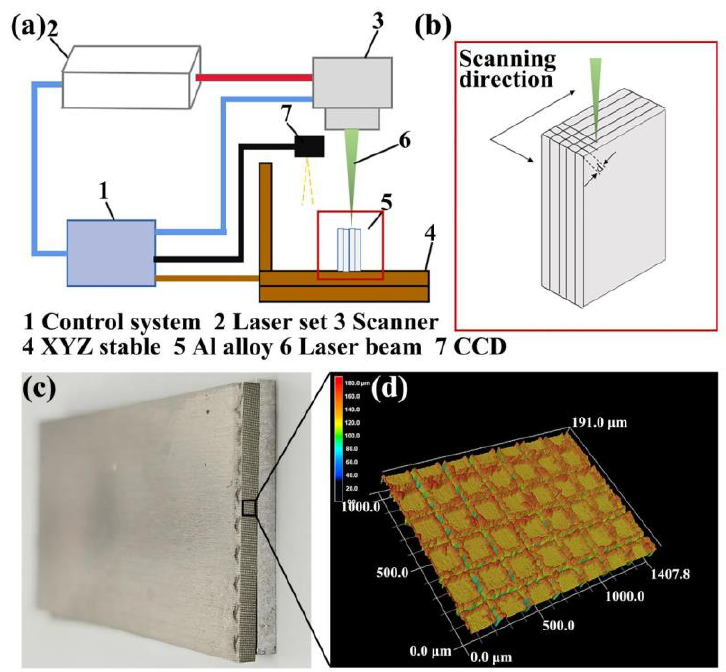
Figure 1. ( a ) Schematic of the picosecond laser processing system for laser micro-texture pretreatment, ( b ) the processing route of laser micro-texturing pretreatment, ( c ) the Al alloys with laser micro-texturing pretreated joining interface, and ( d ) typical morphology of the laser micro-texturing pretreated joining interface by laser scanning confocal microscope (LSCM) with magnification of 400 ×